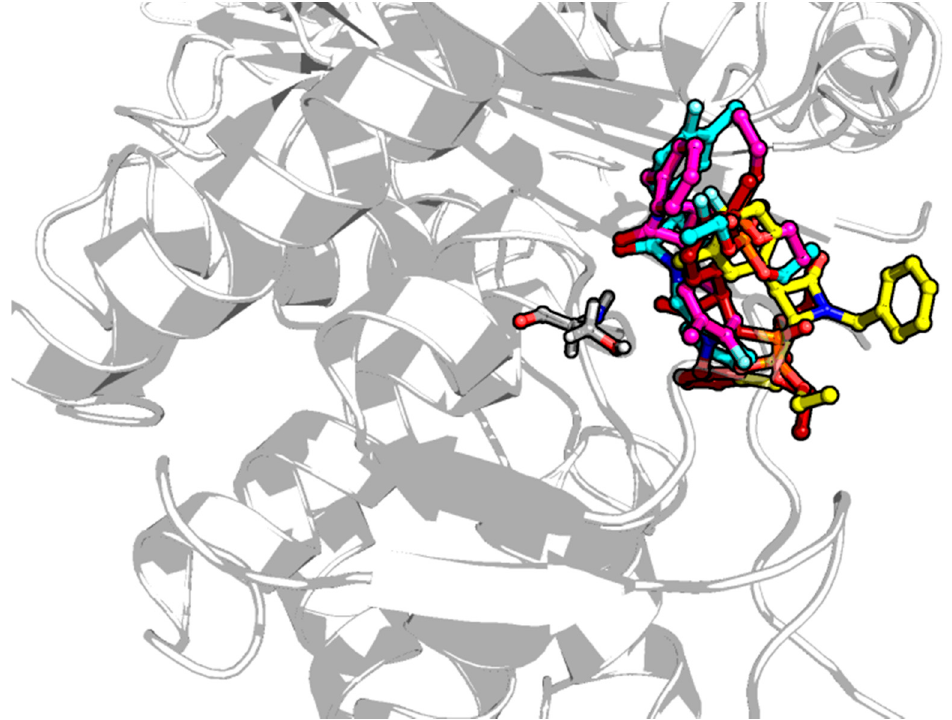
Figure 8. Docking results of various isomers of compound 11f to the PBP2a binding site (S403 resi- due is indicated by sticks): (3 R ,4 R )- 11f –cyan, (3 S ,4 S )- 11f –magenta, (3 S ,4 R )- 11f –yellow, (3 R ,4 S )- 11f